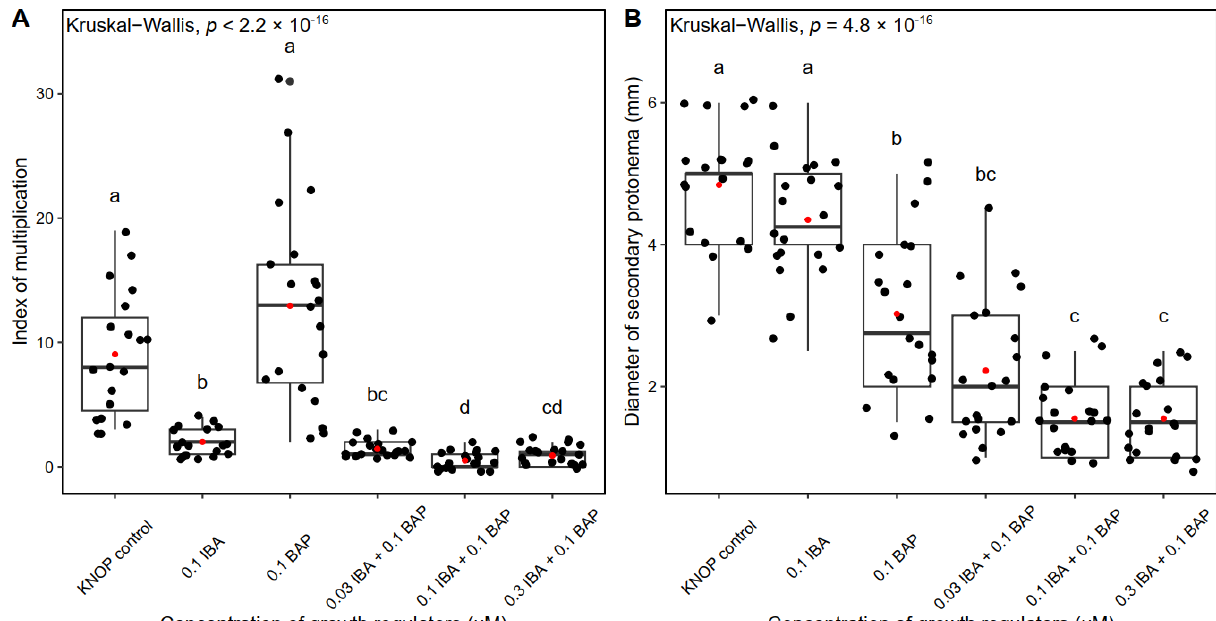
Figure 3. The index of multiplication ( A ) and secondary protonemal patch diameter ( B ) of Pterygoneurum sibiricum on the KNOP nutrient media supplemented with growth regulators in Experiment type II. The box ranges from the first (Q1) to the third (Q3) quartile, with the black horizontal line representing the median. The black dots represent individual observations, while the red dots represent the mean. The whiskers extend to the 1.5 × IQR (interquartile range) from the edge of the box. The letters above the boxplots indicate the statistically significant differences among the experimental groups ( p < 0.05 after Dunn’s multiple comparisons test).